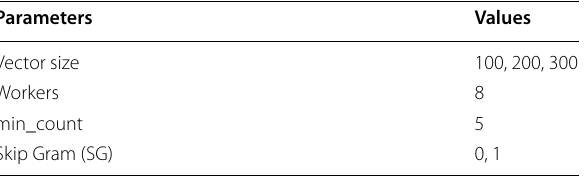
Table 4 Word2Vec parameters used in the study